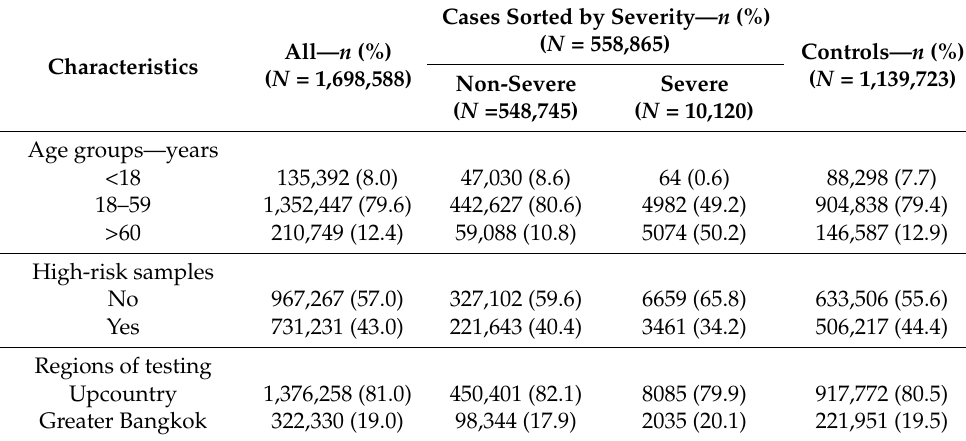
Table 1. Characteristics of the overall study